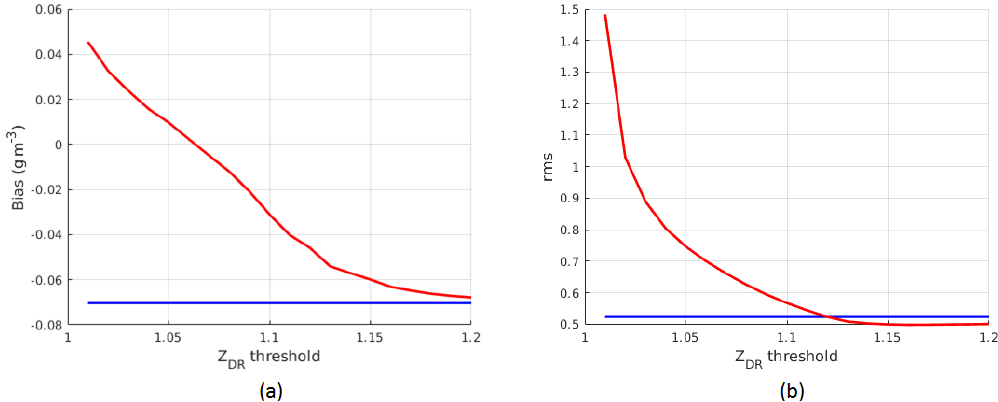
Figure 13. Average bias and rms as a function of Z DR threshold for all data from the seven selected